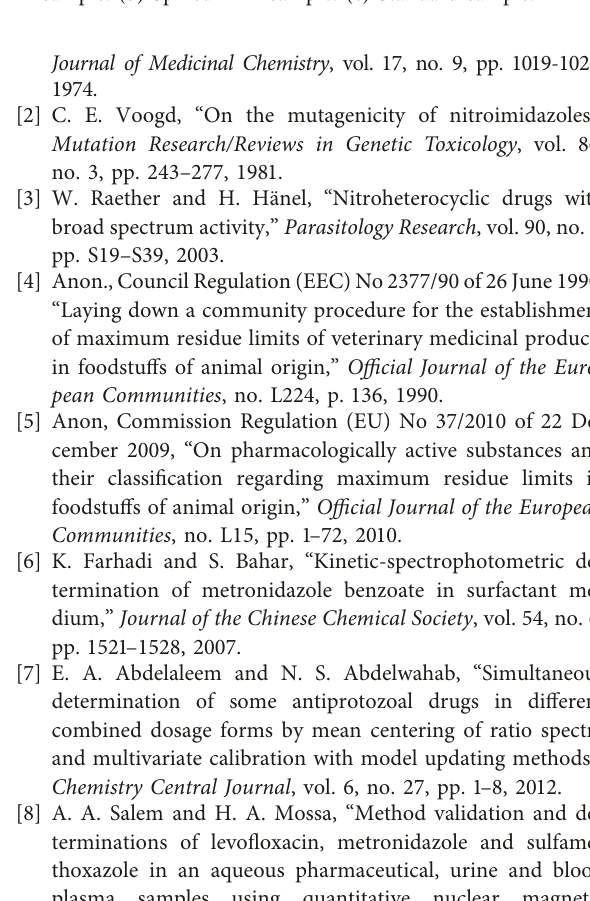
Figure 6: Separation of five 5-nitroimidazole drugs in the milk sample. Electrochromatographic conditions: pH 4.82; voltage: +20kV. Other conditions and the order of peak can be seen in Figure 3. (a) Blank milk sample. (b) Spiked milk sample. (c) Standard